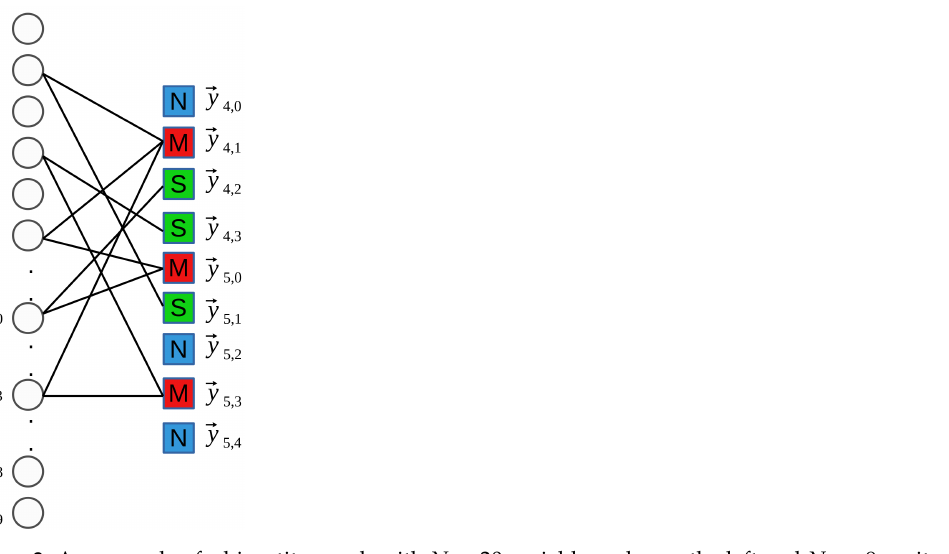
Figure 3. An example of a bipartite graph with N = 20 variable nodes on the left and N b = 9 parity check nodes on the right (blue square with “N” indicates a “zero-ton” bucket, green square with “S” indicates a “single-ton” bucket, red square with “M” indicates a “multi-ton”